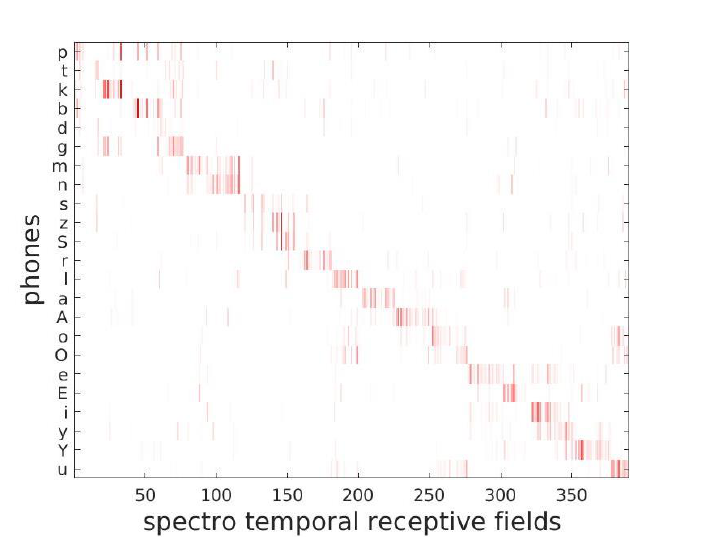
Figure 2. Correspondence between DIANA’s STRFs and frequent phones, organized along broad phonetic classes. Phones are represented using